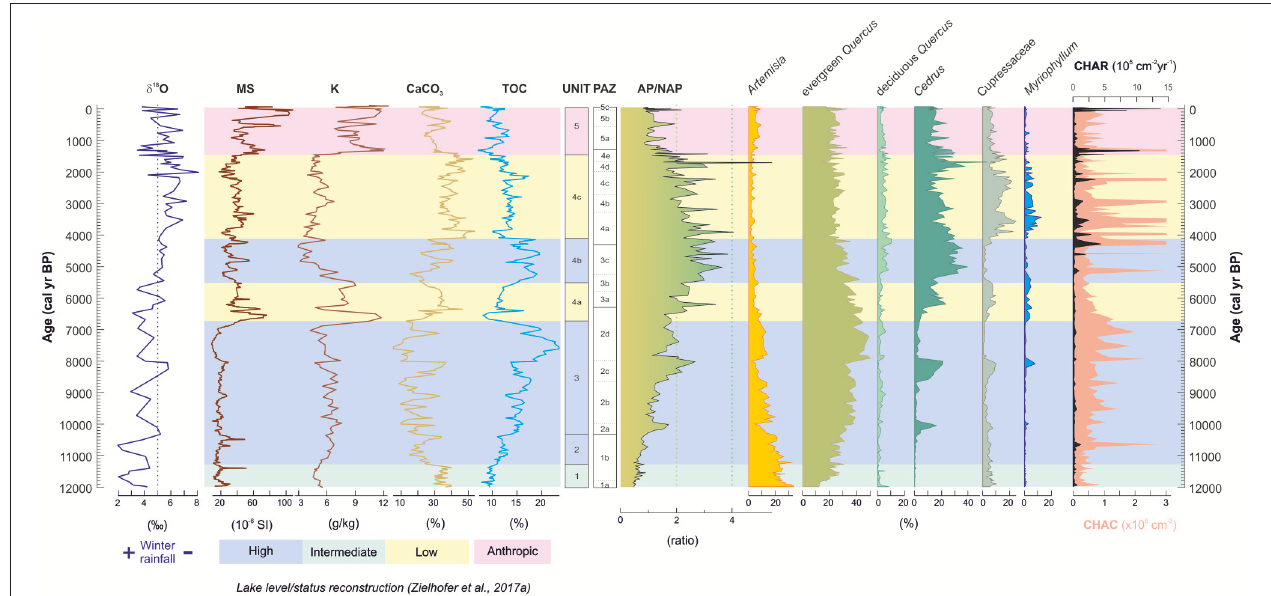
FIGURE 9 | Comparison of hydroclimate, catchment, vegetation and fire proxies at Lake Sidi Ali, showing (from left to right) stable oxygen isotope composition ( δ 18 O) of benthic ostracods, core-scanning magnetic susceptibility, K concentration (benchtop XRF), CaCO 3 and total organic carbon (TOC) content, and sediment unit classification (all data from Zielhofer et al., 2017a) alongside pollen assemblage zones (PAZ), forest cover proxy (AP/NAP ratio), select major pollen taxa, and fire proxies of microcharcoal concentration (CHAC) and microcharcoal accumulation rate (CHAR). Colored shading highlights changes in inferred lake level and human impact on the catchment (Zielhofer et al.,